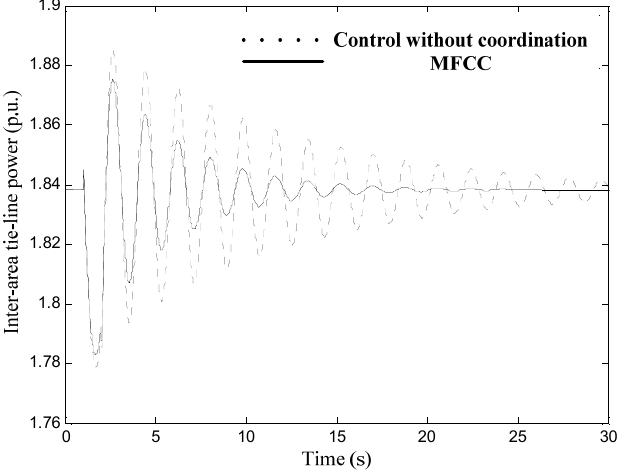
Figure 11. Power oscillation of the tie ‐ line under 200 ms delay.